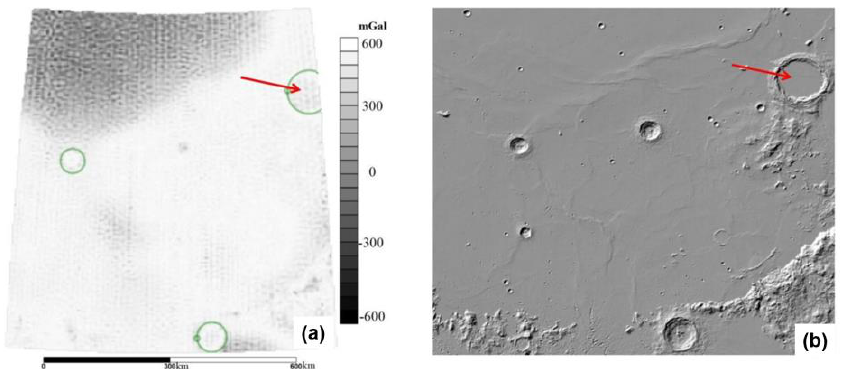
Figure 11. Comparison of crater identification from gravity anomaly map and actual topography in Archimedes Circle Mountain (The red arrow in ( a ) denotes the anomalous profile generated by Archimedes crater, and the red arrow in ( b ) denotes the location and shape of the crater on the DEM map).